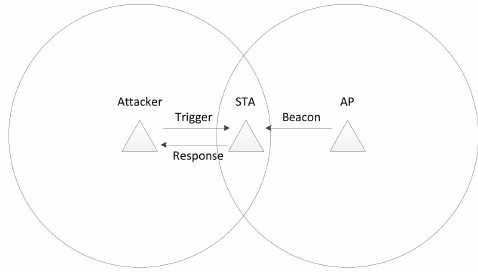
Figure 2. Network configuration for the battery draining attack.